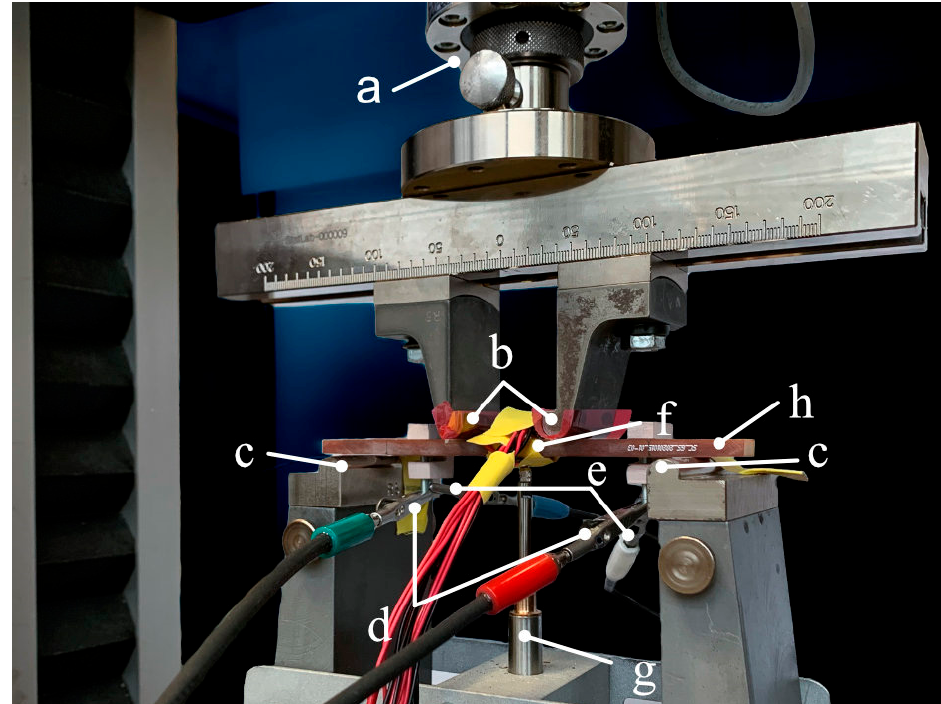
Figure 3. Four-point bending test setup. The GFRP beam (h) with ITFC is shown between the four force entry points (b,c). Four cables (d,e) are connected to the sample for EIS measurement. The power (d) and sense (e) cables are placed separately so as to not interfere with each other. Deformation is detected with a linear position sensor (g), touching the bottom of the sample. Strain is detected with four strain gauges (f) whose cables can be seen running from the middle of the sample to the bottom of the image. Mechanical force is measured via a load cell (a).